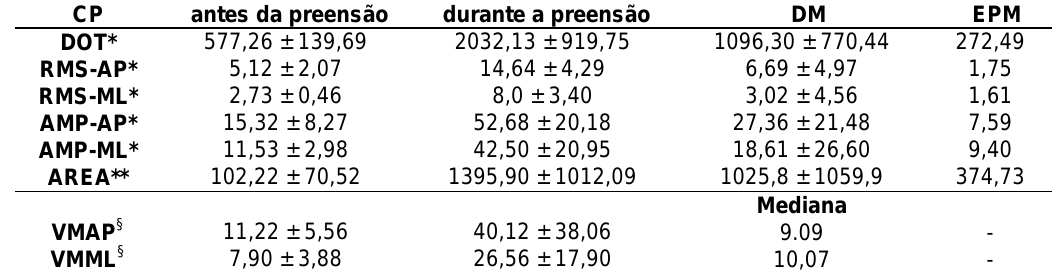
Tabela 1 . Magnitude dos parâmetros do CP antes e durante a realização da preensão manual na mão dominante.